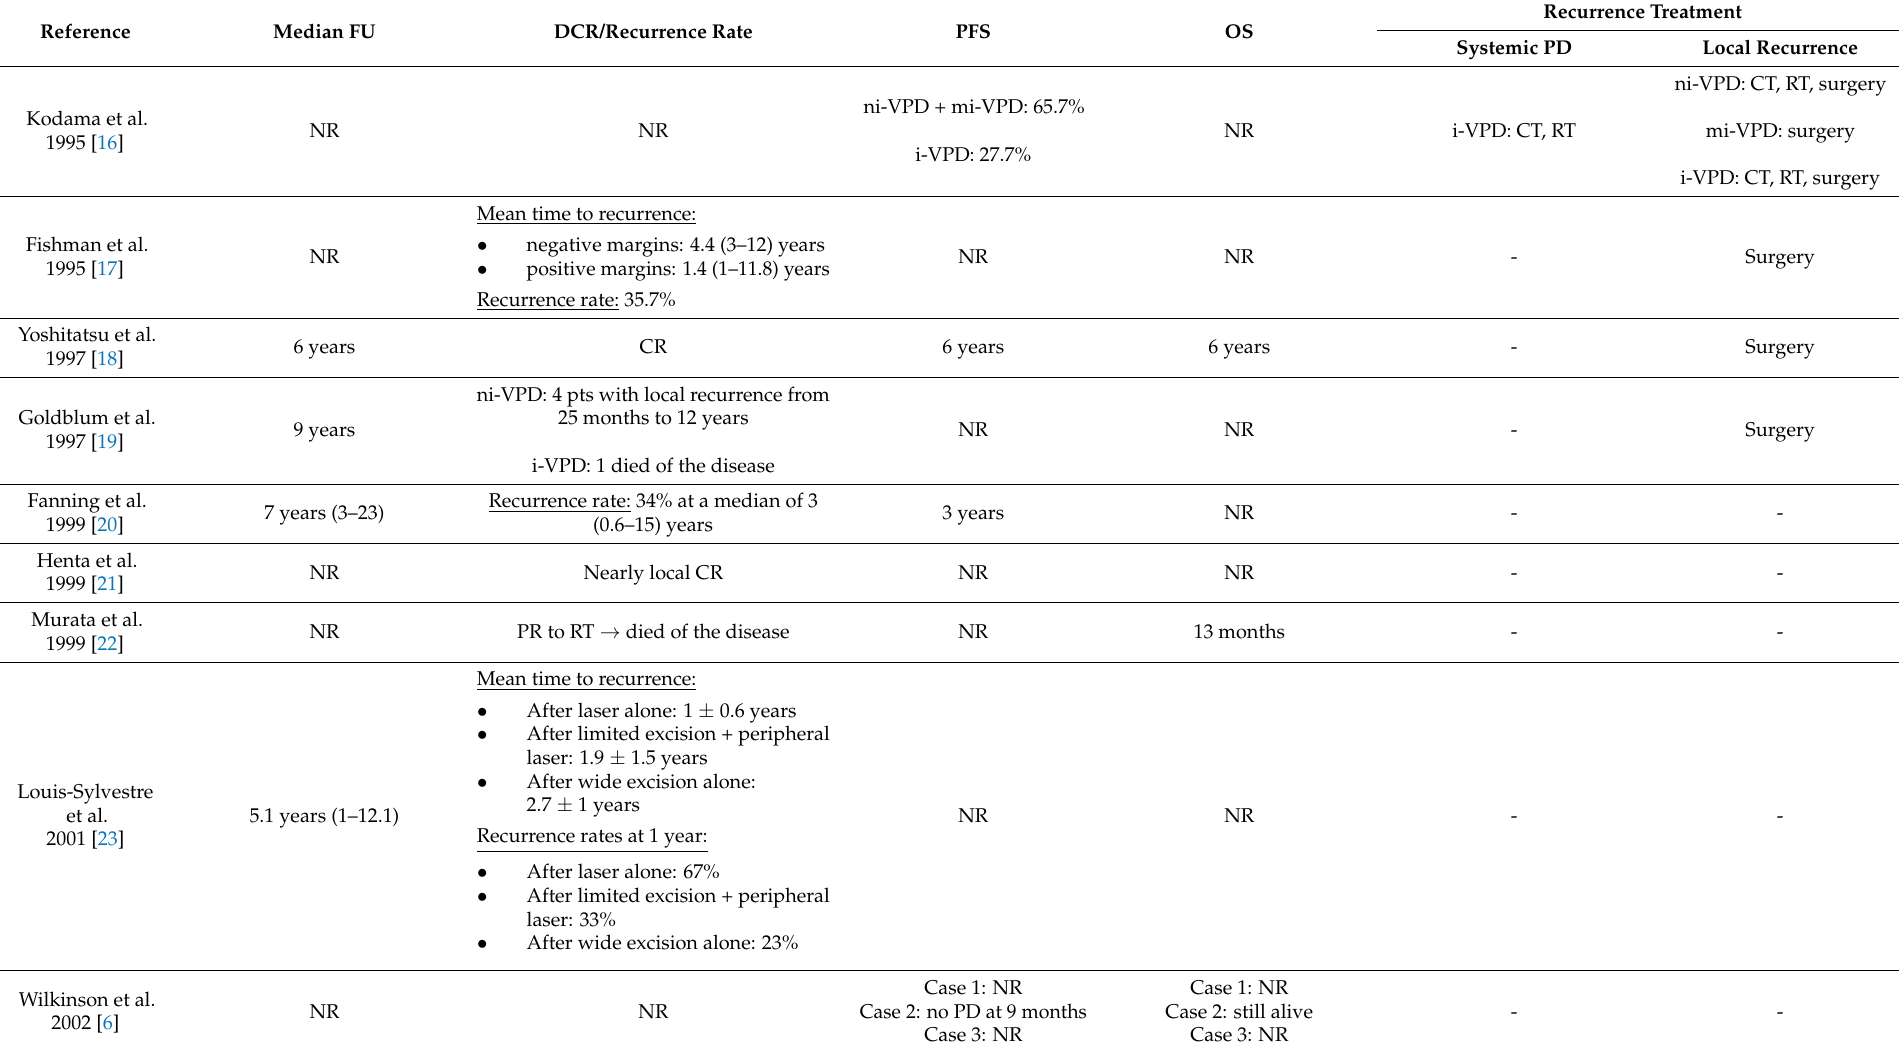
Table 3. Outcomes and recurrence